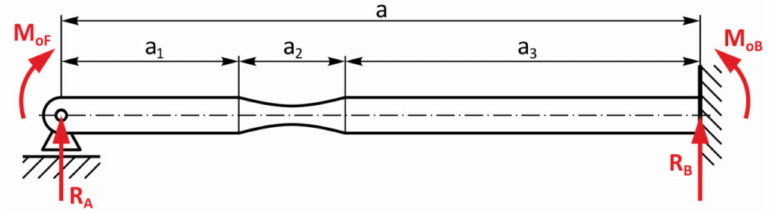
Figure 13. The simplification of the force e ff ects in the specimen—the free body diagram.